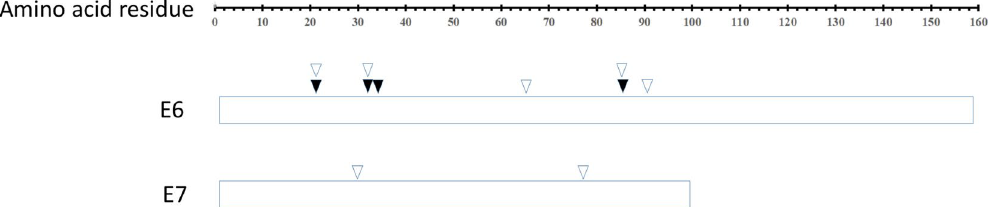
Figure 4. Amino acid changes in CD4 + and CD8 + specific T cell epitopes of HPV16 E6 and E7 proteins. Amino acid changes in at least one of the 51 HPV16 isolates at CD4 + and CD8 + specific T cell epitopes are marked with hollow and solid arrows, respectively. Stacking arrows indicate that the amino acid change is in a peptide which serves as both CD4 + and CD8 +